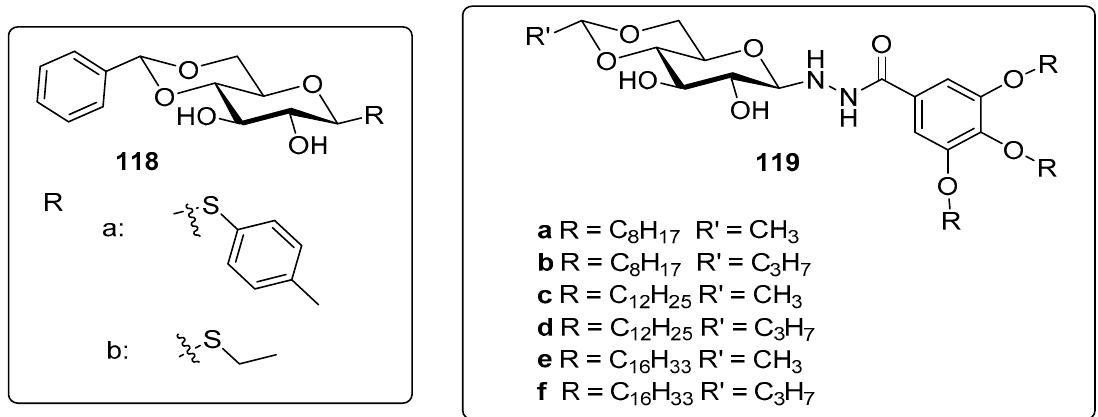
Figure 72. Structure of D-glucose acetal-based gelators 118 and 119 [129,130].